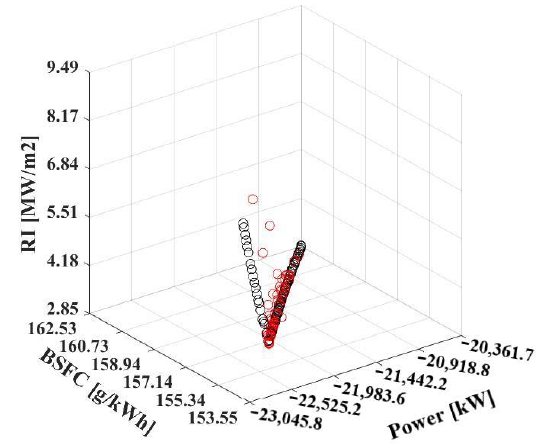
Figure 12. Optimized distribution of MOPSO.